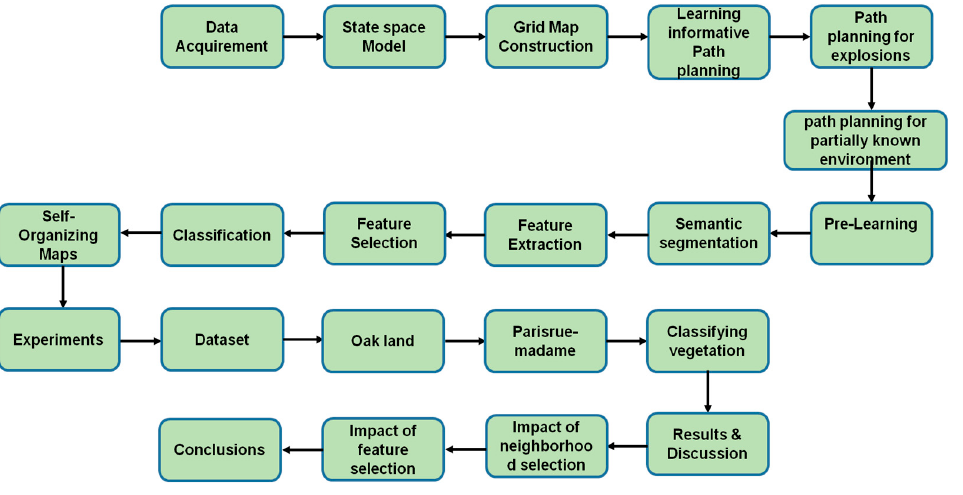
Figure 1. Proposed